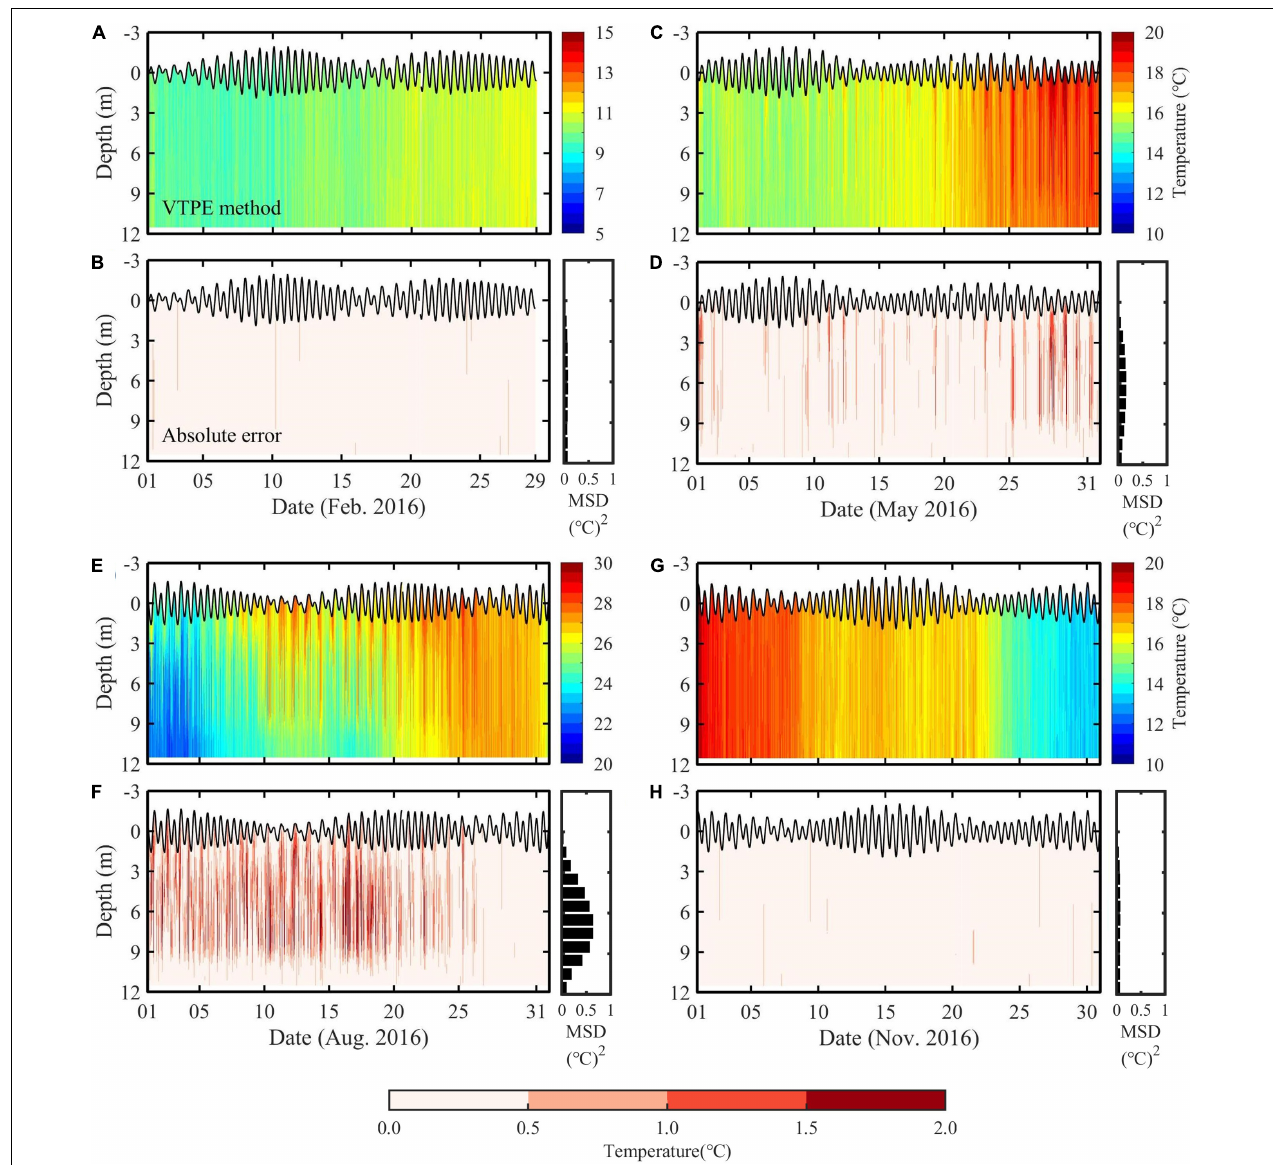
FIGURE 5 | (A,C,E,G) Timeseries of temperature profile estimated with the VTPE method by including the random-error data and (B,D,F,H) absolute errors of the temperature between the output of the numerical model and the VTPE results in (A,B) February, (C,D) May, (E,F) August, and (G,H) November 2016. The colorbar for absolute errors is shown at the bottom. Histograms on the right of (B,D,F,H) represent the vertical distribution of the MSD [( ◦ C) 2 ] in the water column at 1-m intervals.